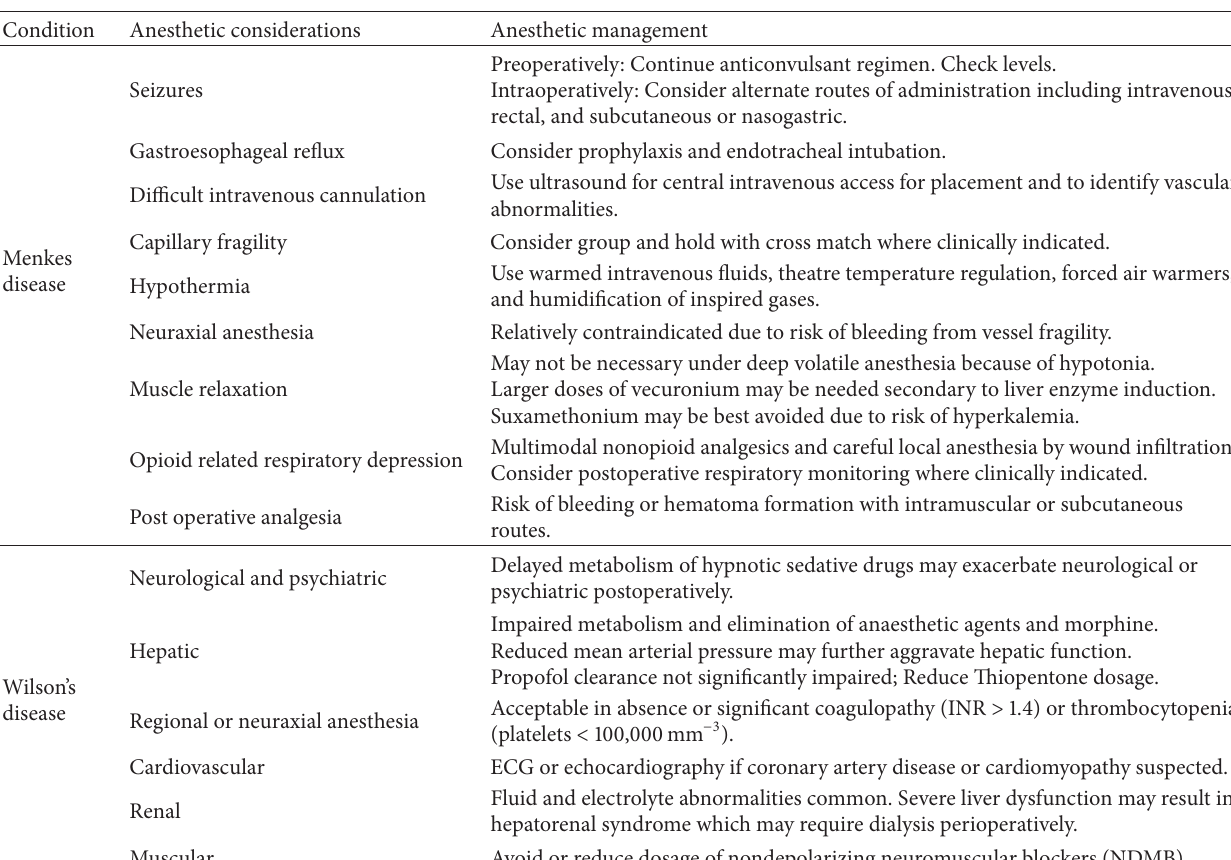
Table 1: Summary of the major anesthetic considerations in the management of patients with Menkes and Wilson’s diseases.